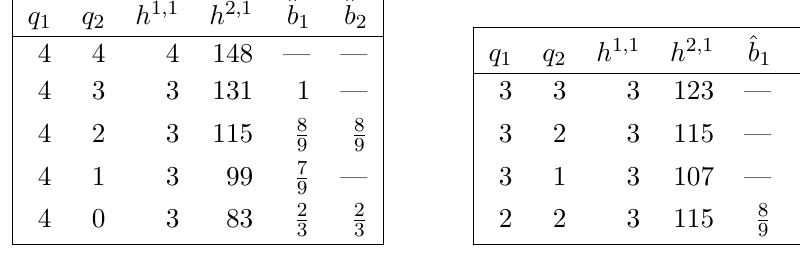
Table 1 . Values for q 1 ; q 2 in (5.9) that lead to re(cid:13)exive polytopes such that the corresponding toric variety is a P 112 (cid:12)bration over P 1 (cid:2) P 1 and the generic Calabi-Yau hypersurface has h 1 ; 1 =